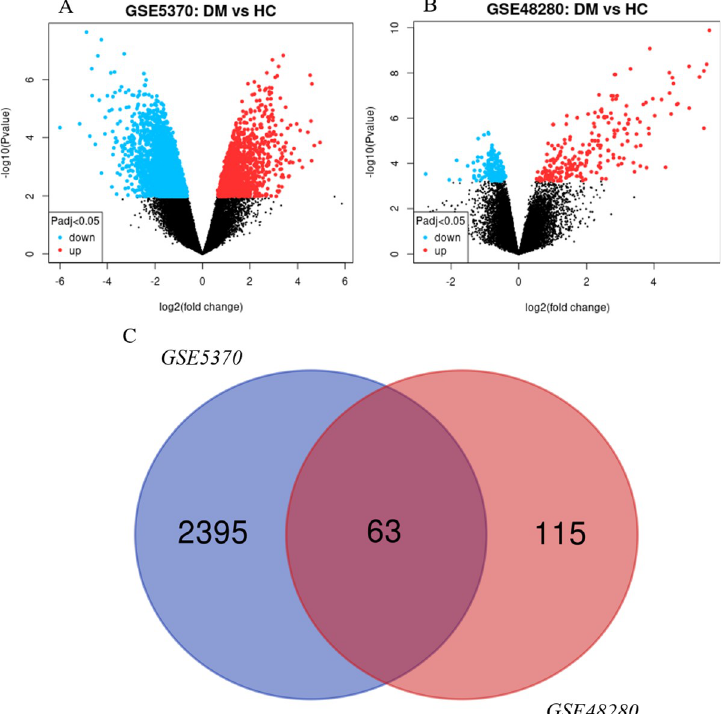
Fig 2. Identification of DEGs. (A) Volcano plot of GSE5370, (B) Volcano plot of GSE48280, and (C) Venn diagram of common DEGs from the two datasets. Data points in red and blue represent upregulated and downregulated genes,